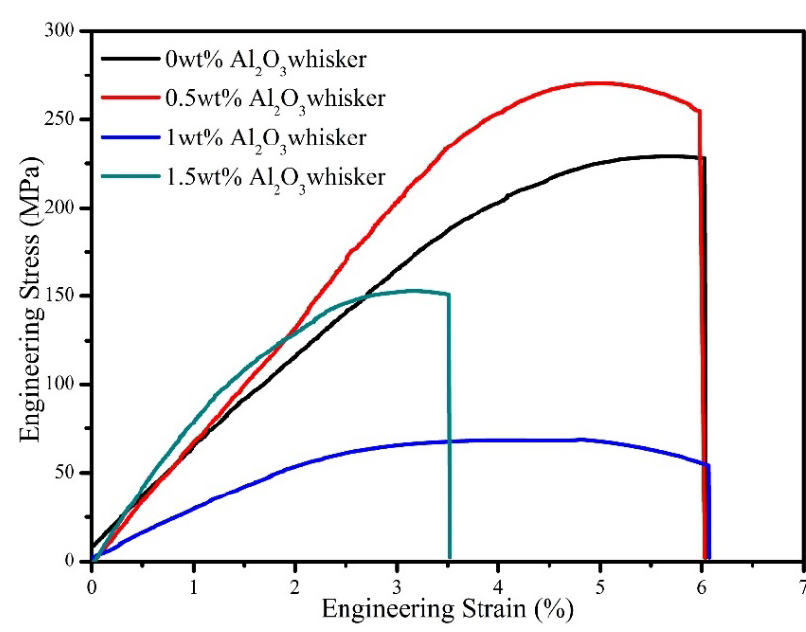
Figure 9. Compressive stress strain curve of sintered composites reinforced with different content of alumina whiskers.